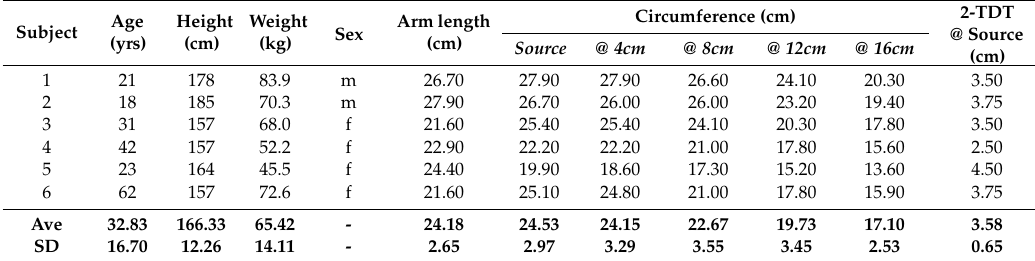
Table A2. Subject demographics showing age, height, weight, arm length, and arm circumferences along the arm.